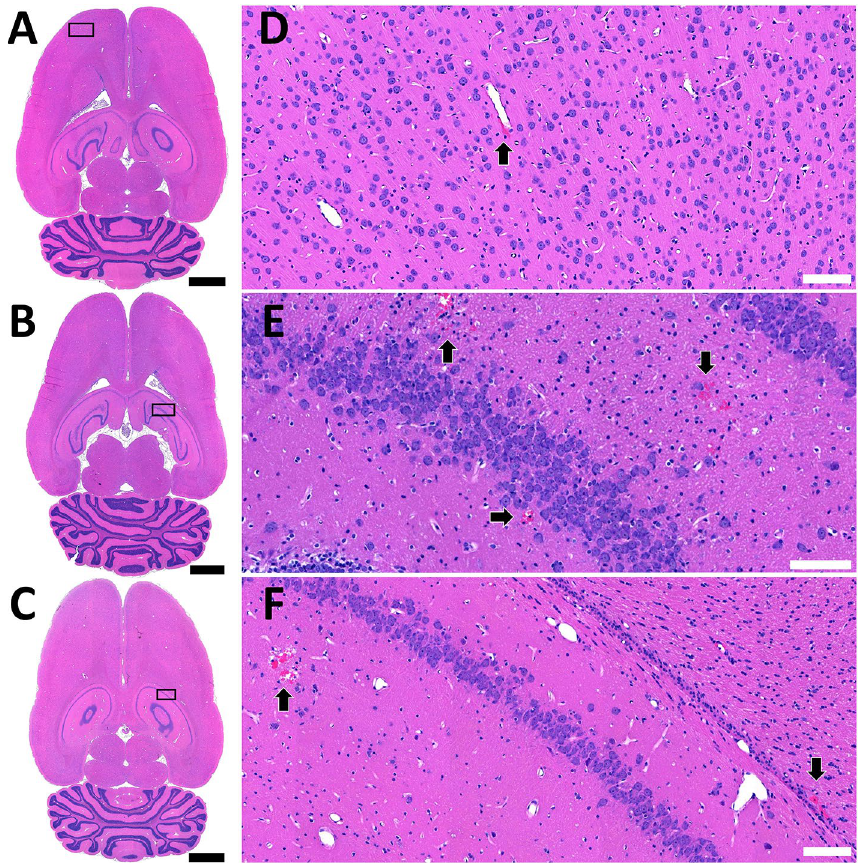
Figure 5. Red blood cell extravasation. Overt tissue damage in cohort #2 animals was assessed at 24 h and 7 days following sonication in H&E stained sections. No evidence of red blood cell (RBC) extravasation was evident at 7 days for any sonications. The largest regions of RBC extravasation 24 h following focused ultrasound and microbubble exposure (cohort #2a) are depicted for sonications with ( A , D ) Definity, ( B , E ) BG8774, or ( C , F ) MSB4 in circulation. White arrows highlight regions of RBC extravasation. Black scale bars = 2 mm. White scale bars = 100